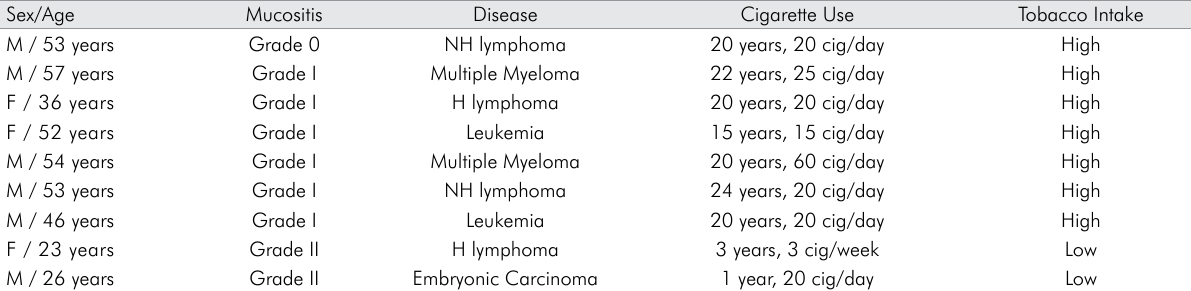
table 4. Former smokers and the presence of oral